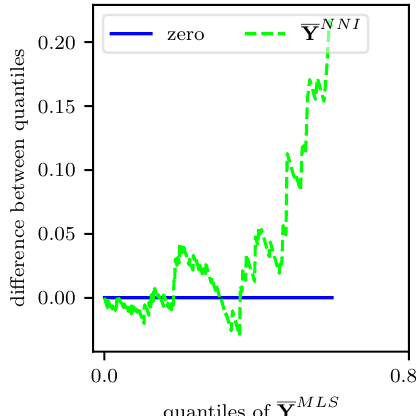
Figure 5. Quantile plot showing the frequency distributions of the results of Monte-Carlo simulations for RSMs, using different response surface methods in comparison to the RSM of